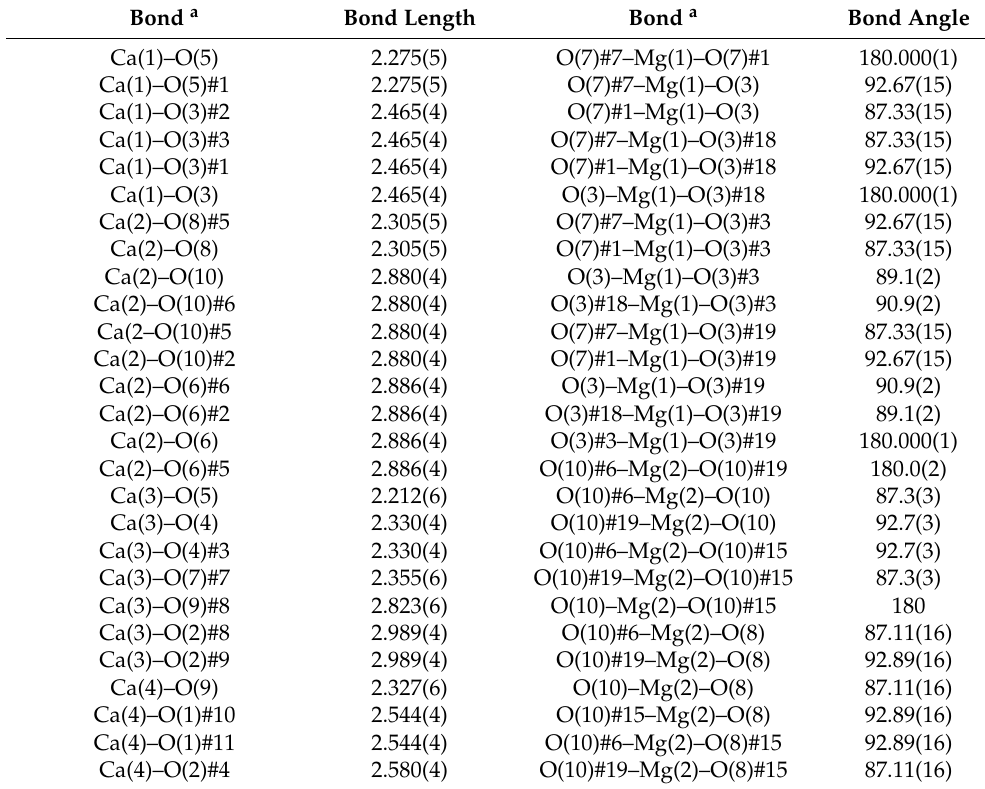
Figure 2. Polyhedral views of ( a ) Ca 7 MgSi 4 O 16 -Bre structure in space group Pnnm and ( b ) [Mg–O–Si] chains. Table 2. Atomic coordinates (x, y, z) and equivalent isotropic displacement parameters (U(eq)) for Ca 7 MgSi 4 O 16 -Bre ( Pnnm ). Table 3. Selected bond lengths (Å) and angles ( ◦ ) for Ca 7 MgSi 4 O 16 ( Pnnm